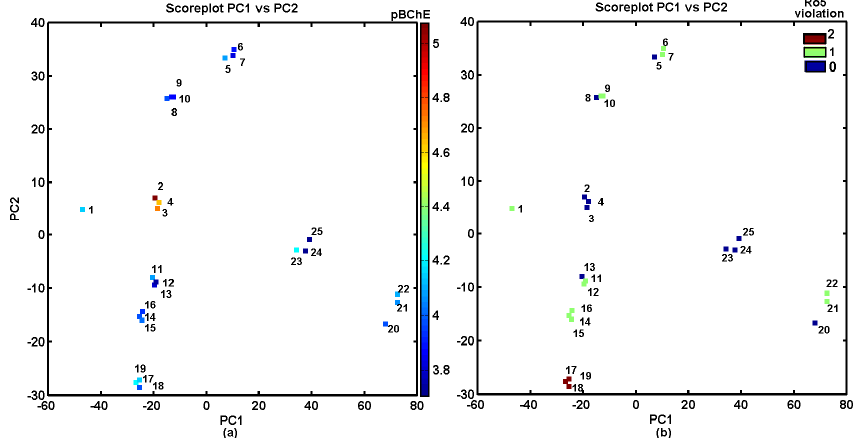
Figure 1. Projection of carbamates 1 – 25 on the plane defined by the first versus second principal components for Dragon descriptors with BChE activity on the logarithmic scale ( a ) and rule of five violations ( b ). Colors indicate the numerical values of pBChE activity and rule of five (Ro5) violations.